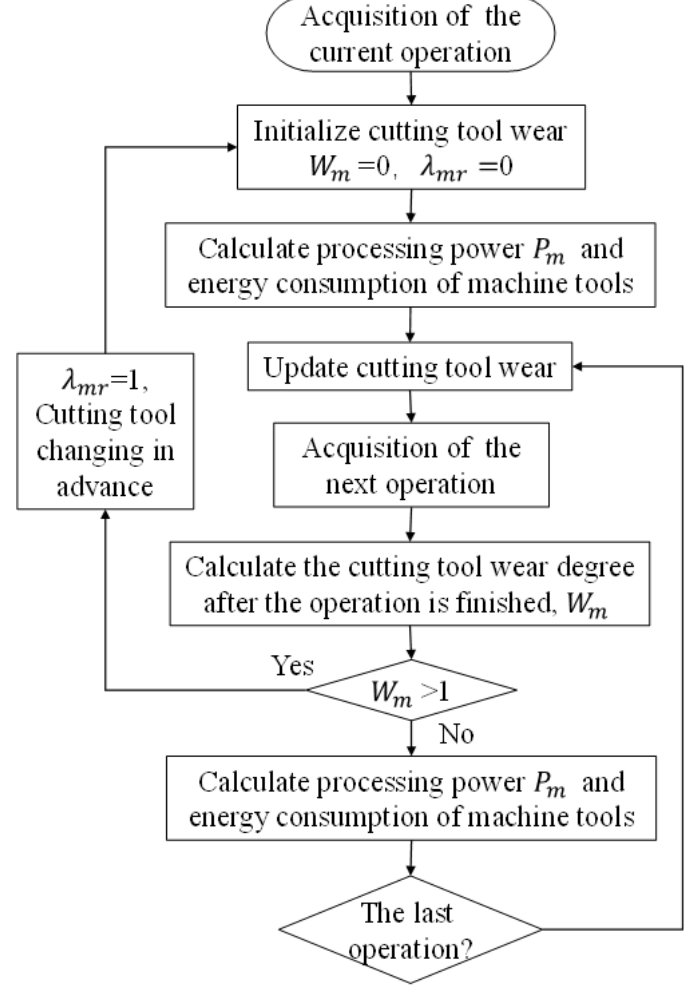
Figure 4. Cutting-tool degradation mechanism.